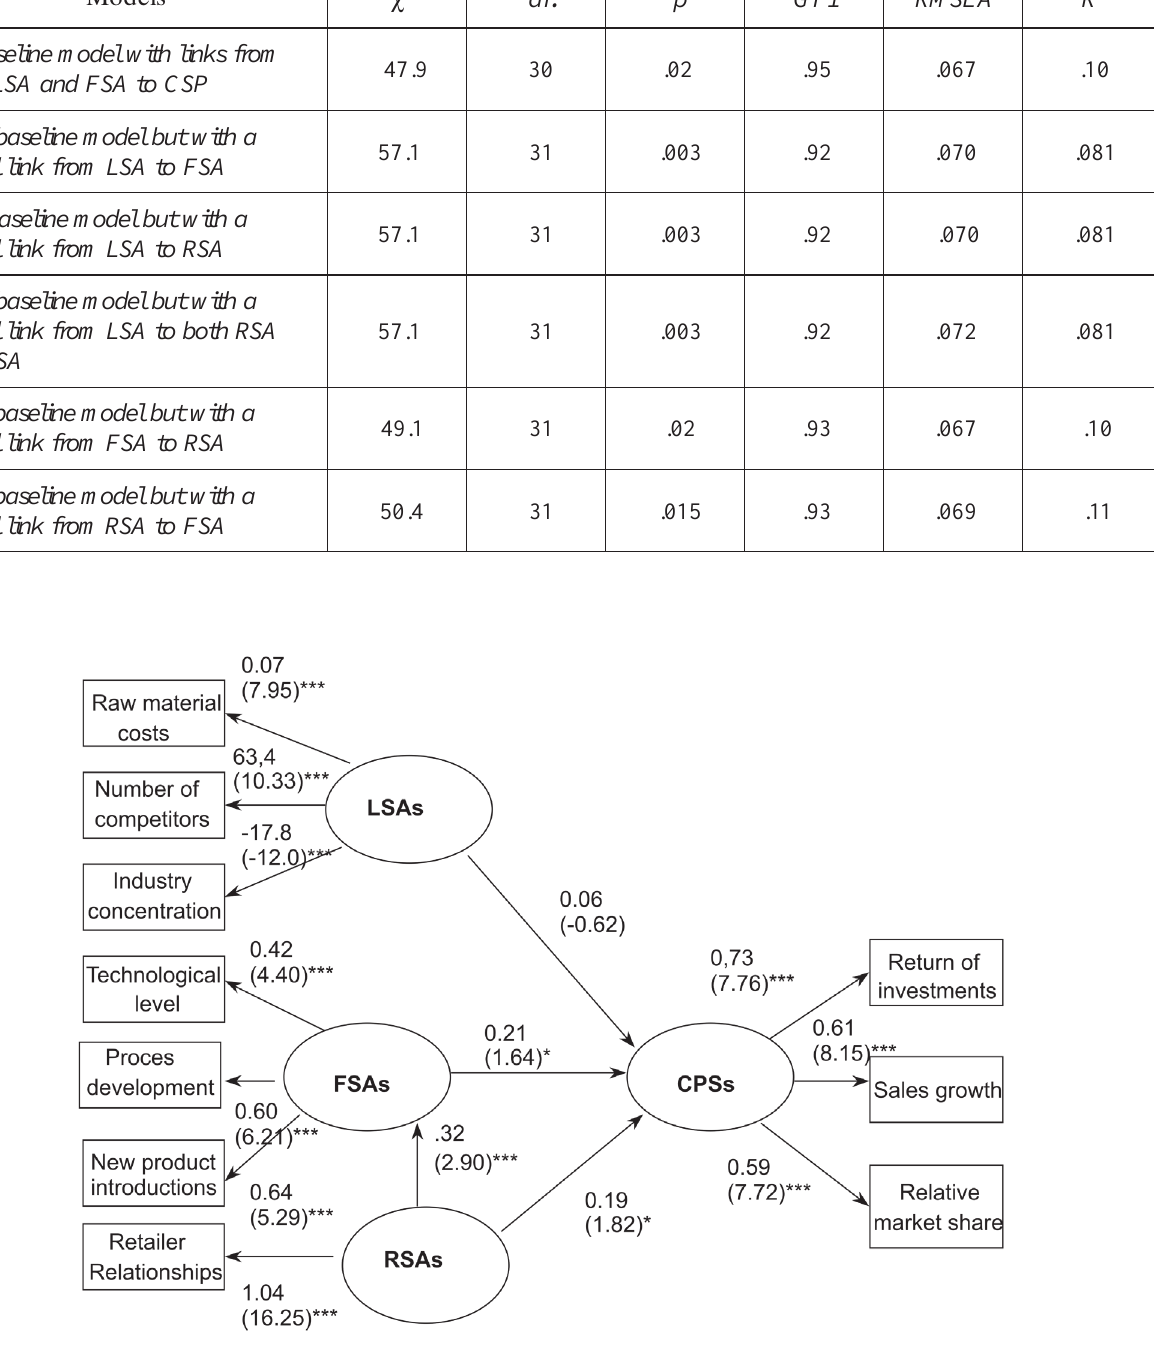
Fig 2. LISREL model of sources of competitive advantages and the links to performance: Coefficient estimates (non-standardized) and t-values (in